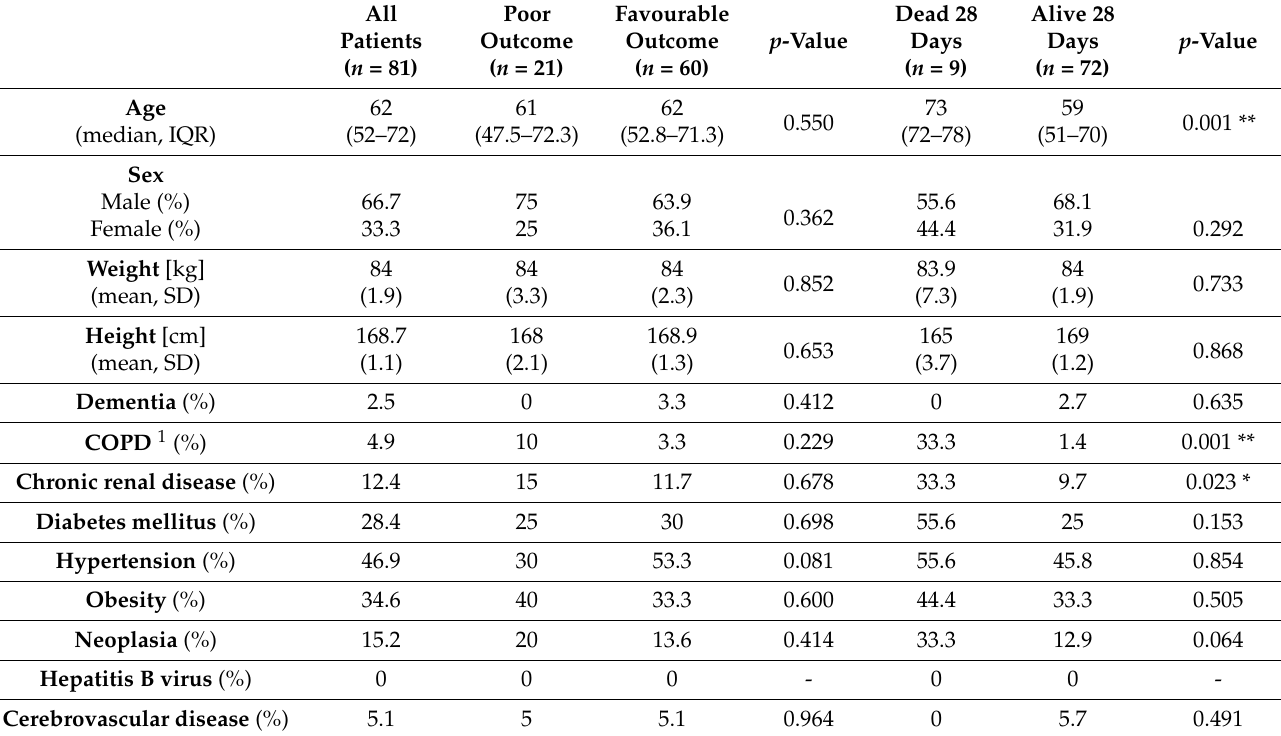
Table A1. Clinical, analytical and imaging characteristics of